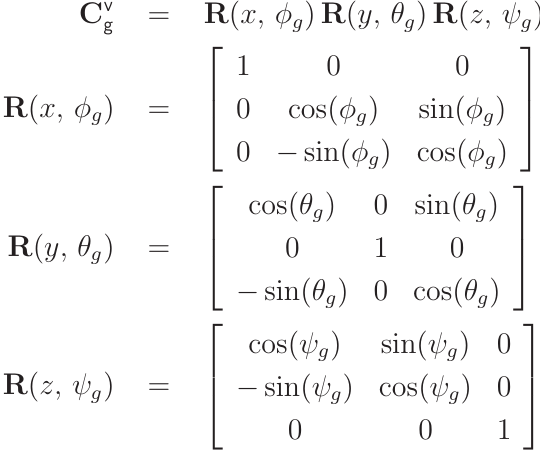
Figure 1. A schematic plot a vehicle and four coordinate systems (global frame, road frame, vehicle frame and auxiliary